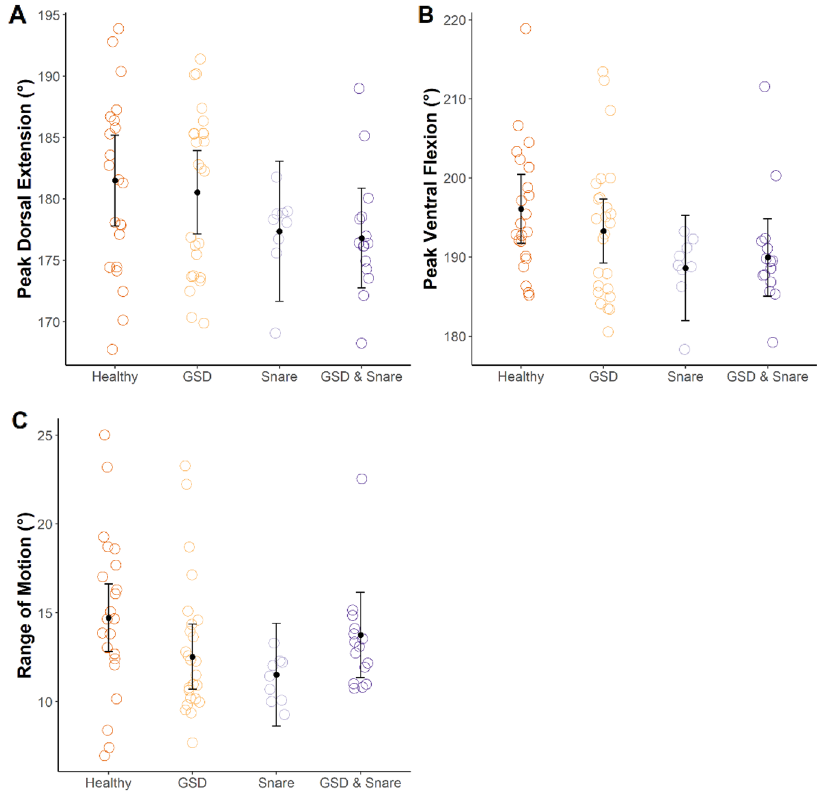
Figure 5. Variation in neck angle kinematics among different conditions (i.e., healthy, GSD, snare wound, and both GSD and snare wound) in free-ranging Nubian giraffe Giraffa camelopardalis camelopardalis from Murchison Falls National Park, Uganda. Each point represents a stride. Black dots indicate estimated marginal means and black error bars indicate 95% confidence intervals from the linear mixed